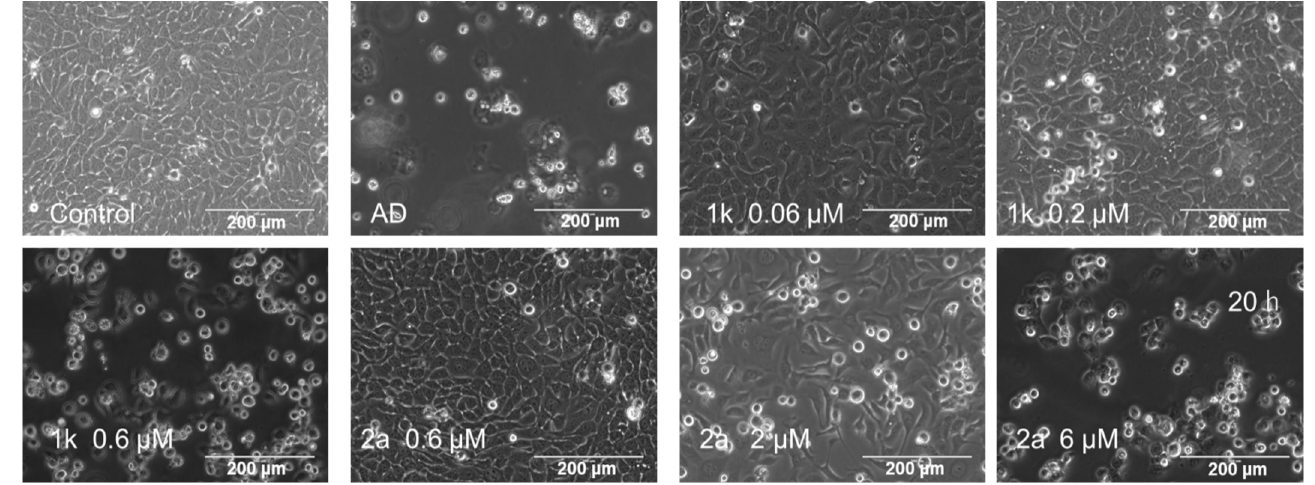
Figure 4. Increased mitosis in Ca9-22 cells after treatment with 1k , 2a, and actinomycin D(AD). Cells were treated without (control) or with 1 µ M actinomycin D or the indicated concentrations of 1k and 2a in the presence of the DMSO vehicle